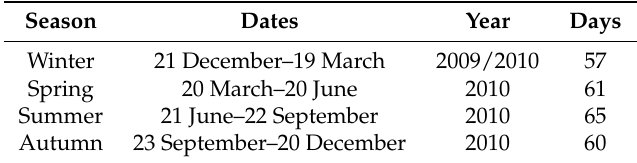
Table 1. Data division for each season, in accordance with the Irish calendar.